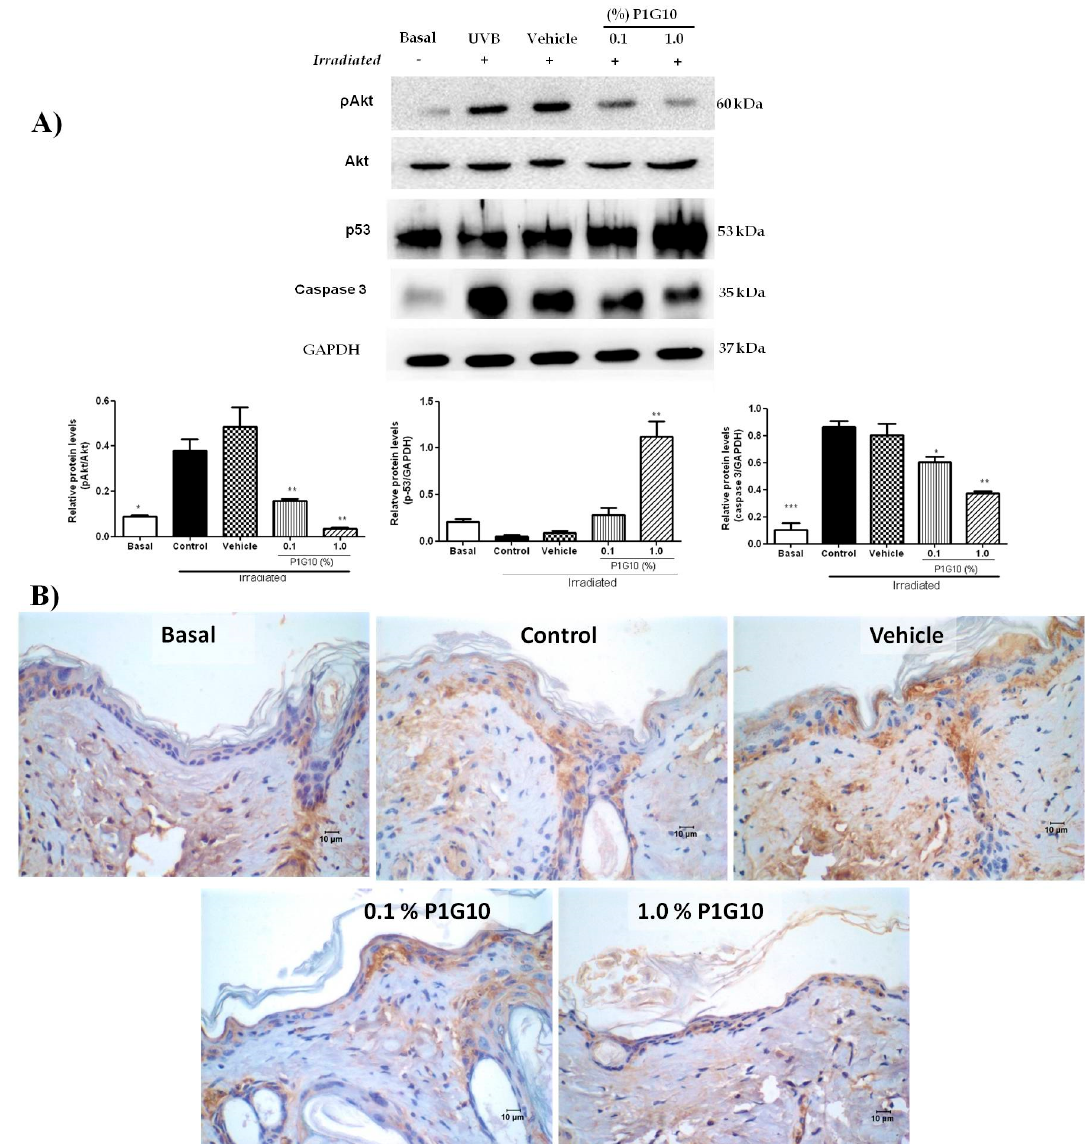
Figure 9. P1G10 alters the expression of pakt, p53, and caspase-3 in irradiated skin. Mice were exposed to UVB (2.4 J cm − 1 ) and treated with Natrosol gel (vehicle) or 0.1% and 1% P1G10. After 24 h, the skin of euthanized animals was dissected and processed for analysis. Cell lysates were used to assess pakt, p53, and caspase-3 ( A ). The data show a western blot and densitometric analysis. Protein levels were normalized to GAPDH using ImageQuant software. ( B ) A brown color indicates the presence of caspase-3 positive cells in irradiated samples. Images captured with 40 × objective, Scale = 10 µ m. Results represent the mean ± SEM of 6–8 animals per group (* p < 0.05, ** p < 0.01 and *** p < 0.001 di ff erence versus vehicle, ANOVA, Newman–Keuls post-test).